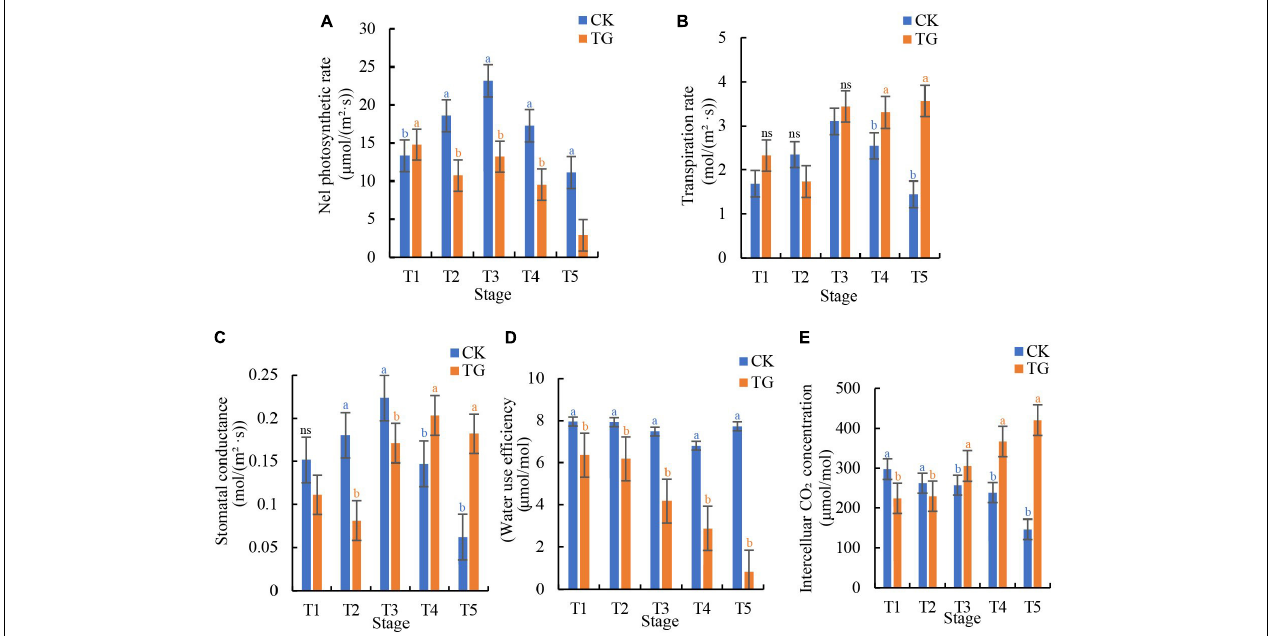
FIGURE 5 | Sclerospora graminicola caused damage on the photosynthesis of foxtail millet. (A) The net photosynthetic rate of CK and TG at T1–T5 stages; (B) the transpiration rate of CK and TG at T1–T5 stages; (C) the stomatal conductance of CK and TG at T1–T5 stages; (D) the water use efficiency of CK and TG group at T1–T5 stages; (E) the intercellular CO 2 concentration of CK and TG at T1–T5 stages.